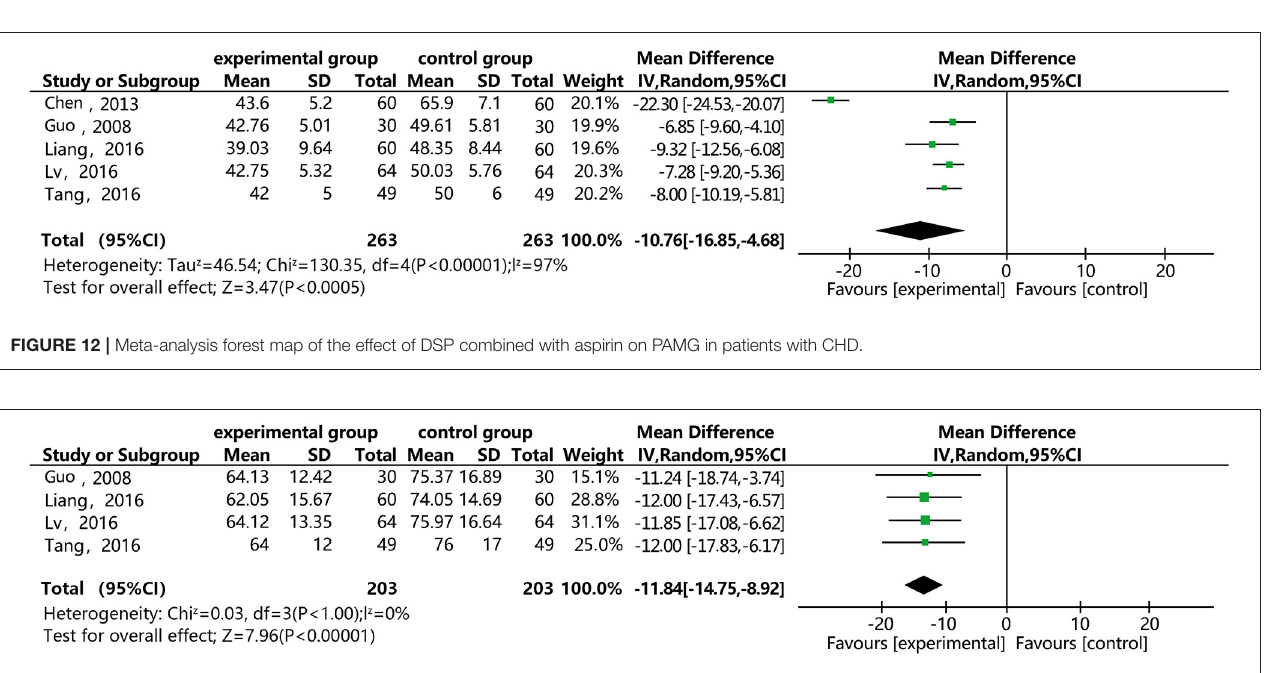
FIGURE 13 | Meta-analysis forest map for the effect of DSP combined with aspirin on TXB 2 in patients with